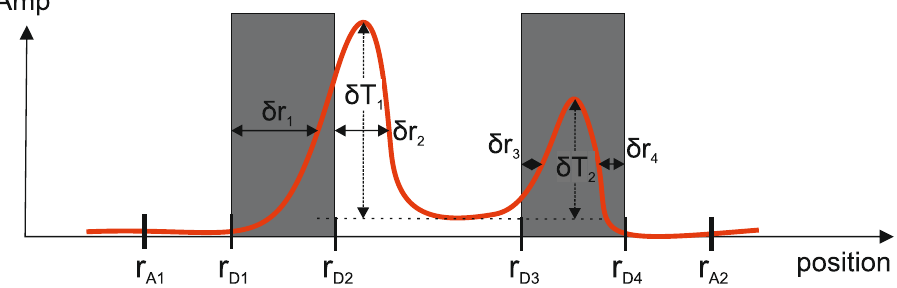
Figure 5. Explanation of metrics for QNDE: δ T and δ r . The red curve illustrates an exemplary a rec and the grey defect pattern shows the corresponding exemplary a